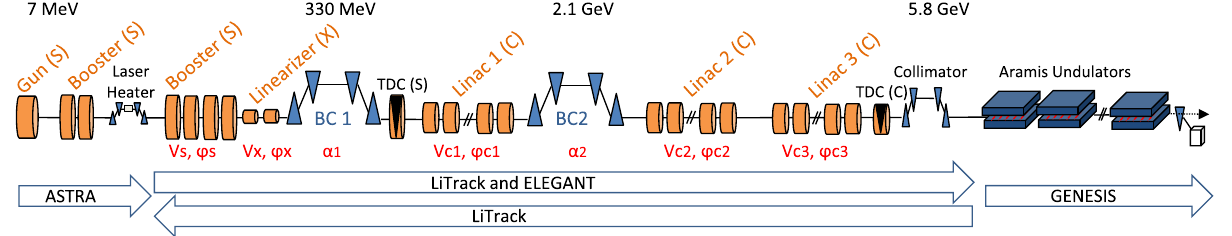
1. SwissFEL layout including the S -band photocathode gun and boosters, the X -band linearizer cavity, the C -band linacs and the two bunch compressors. Two transverse deflector cavities, one situated after the first bunch compressor and the other at the end of the linac, will be used for longitudinal diagnostics. The lattice variables that are used in the optimization of the compression scheme are indicated in red, under their corresponding component. The different codes used to perform start-to-end tracking simulations, their range of usage and tracking direction (forward/backward) are indicated with the arrows below the lattice